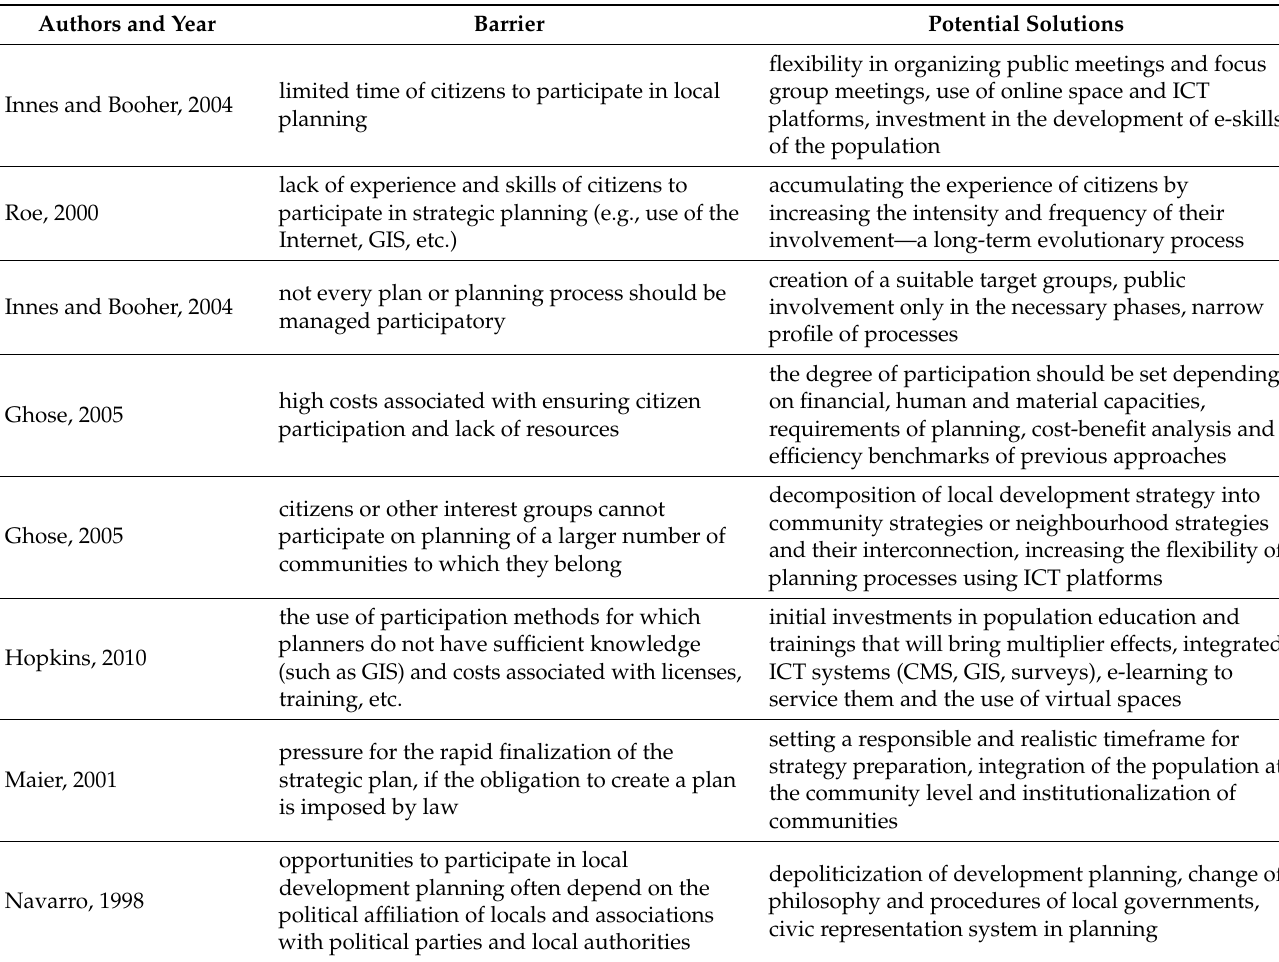
Table 1. An overview of barriers to the development of public participation in formal strategic planning. Authors and